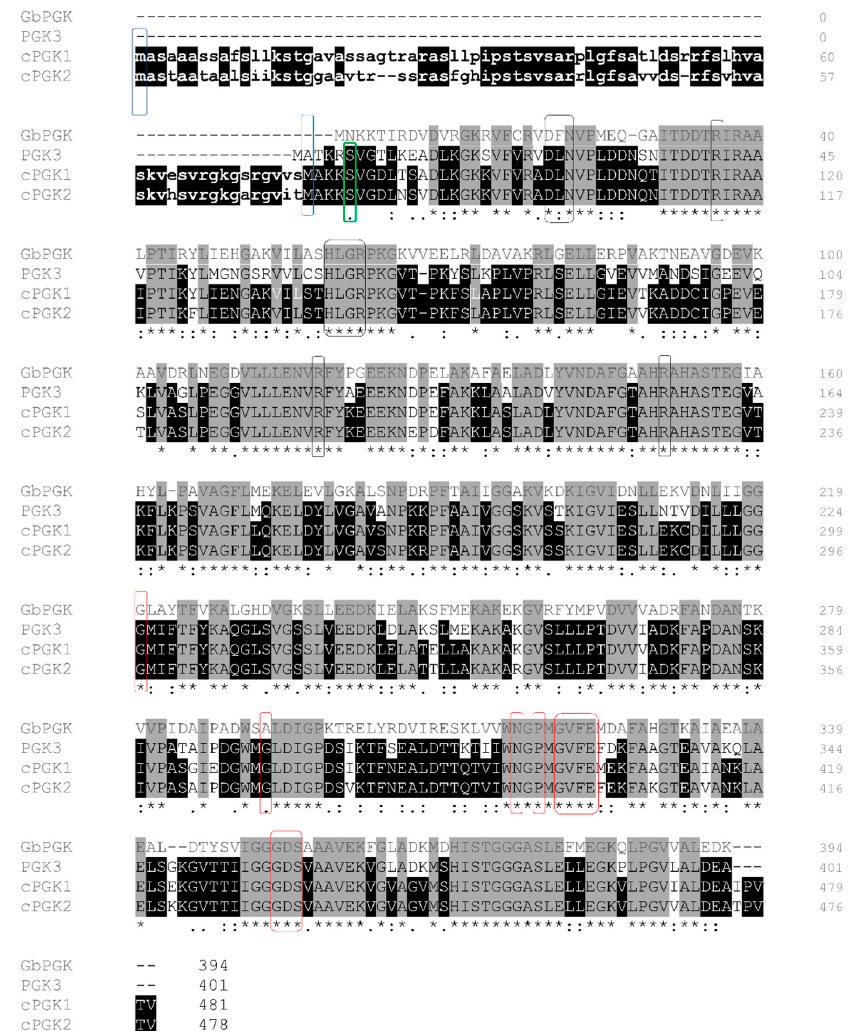
Figure 1. Sequence alignment of Arabidopsis thaliana and Geobacillus stearothermophilus PGKs protein sequences show a high sequence identity between plants and bacterial PGKs. Arabidopsis cPGK1 (At3g12780), cPGK2 (At1g56190), and PGK3 (At1g79550) are aligned with the bacillus PGK (P18912) using MUSCLE (https://www.ebi.ac.uk/Tools/msa/muscle/, accessed on 18 June 2021). Amino acid sequences of the chloroplastic isoforms begin with a transit peptide (TP, in lowercase) that starts with methionine 1. Methionine 2 (blue boxed methionine) is present in cPGK1 (Met77) and cPGK2 (Met74) sequences in the first exon. Conserved residues between the 4 sequences are shown in the grey background, and conserved residues between the Arabidopsis PGKs are shown in the black background. Amino acid residues involved in 3-PGA binding are black boxed and those involved in ADP binding are red boxed. Conserved S78 residue substituted by G78 in the Cvi ecotype displaying resistances to potyviruses [24] is green boxed.